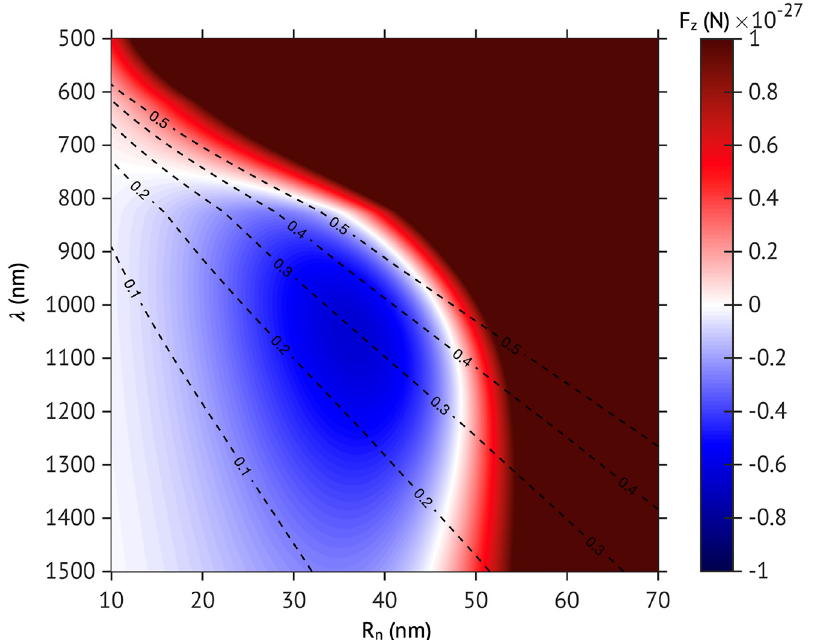
Figure 3a can be categorized into a kind of ‘ A ’ . Thus, it is most likely that this nanobubble size will initiate the for- ward motion, and it may be dif fi cult to activate the back- ward motion.